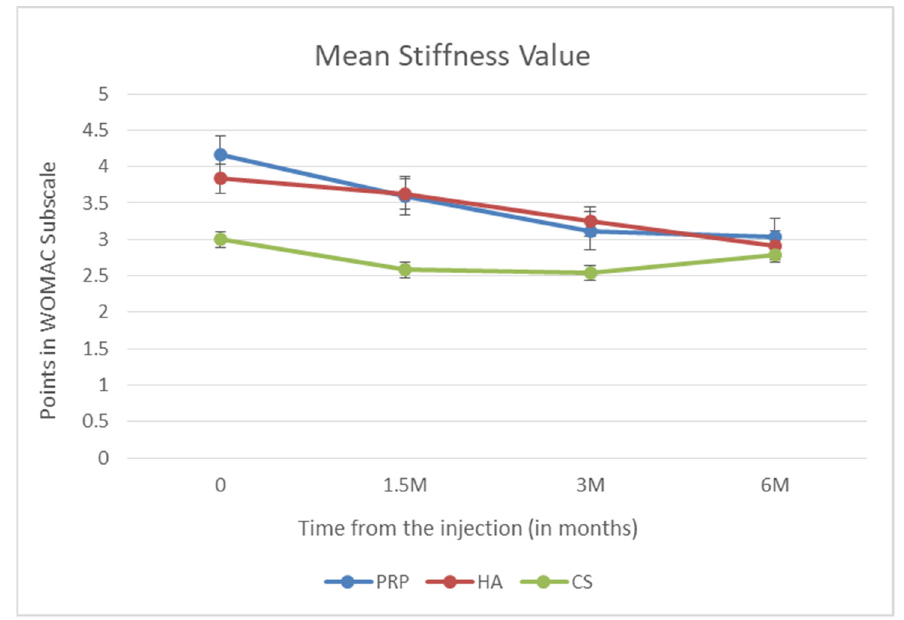
Figure 3. Mean stiffness value (points in WOMAC subscale).